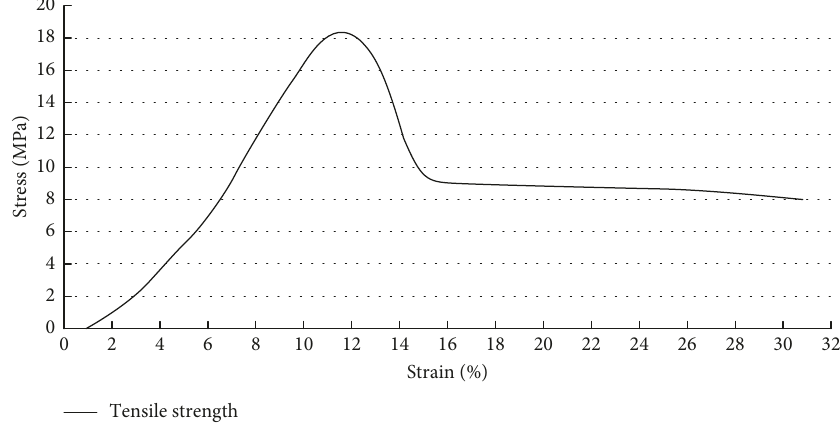
Figure 2: Tensile stress-strain curve of the elastic epoxy.